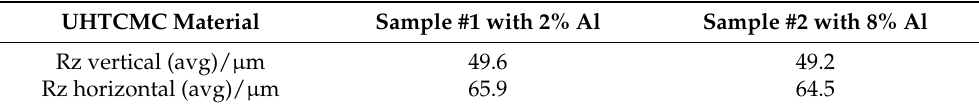
Figure 4. Front surface of the UHTCMC material. Table 2. Measured roughness values for the surface of two samples.